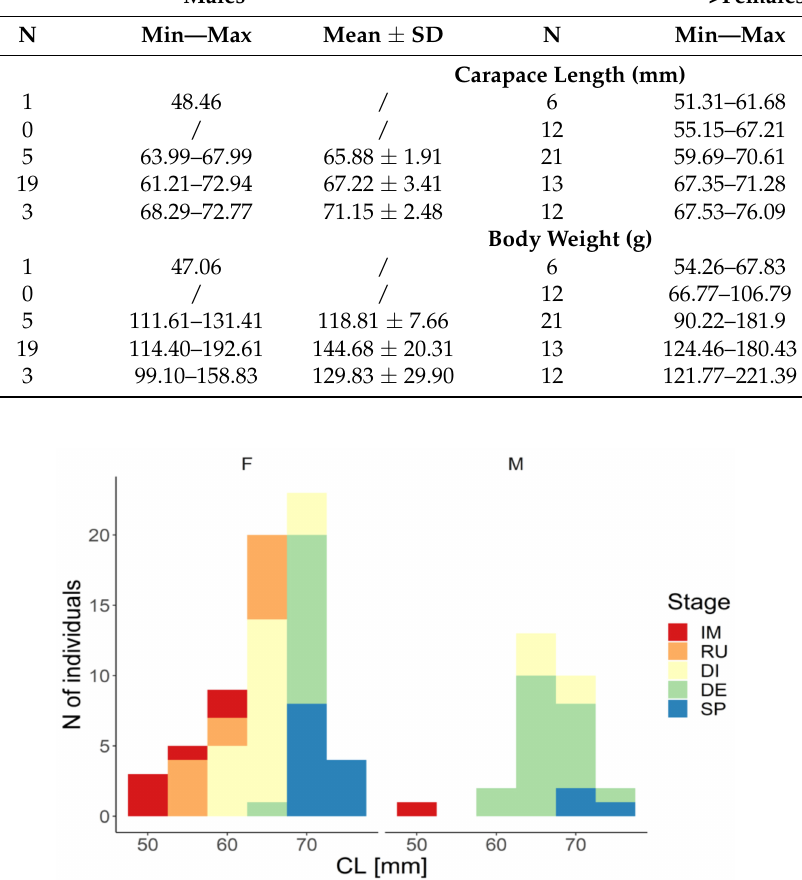
Figure 4. Distribution of female (F) and male (M) Calappa granulata maturity stages (IM—immature, RU—rudimentary, DI—developing, DE—developed, SP—spent) presented in 4 mm carapace length (CL) size classes. The specimens were caught in the central eastern Adriatic